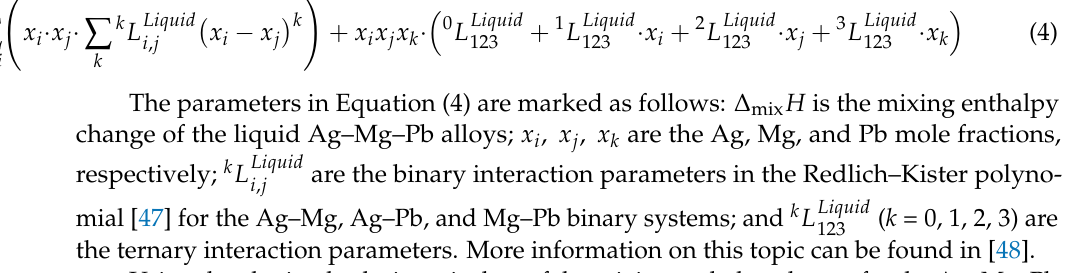
and ternary interaction parameters k L Liquid i , j